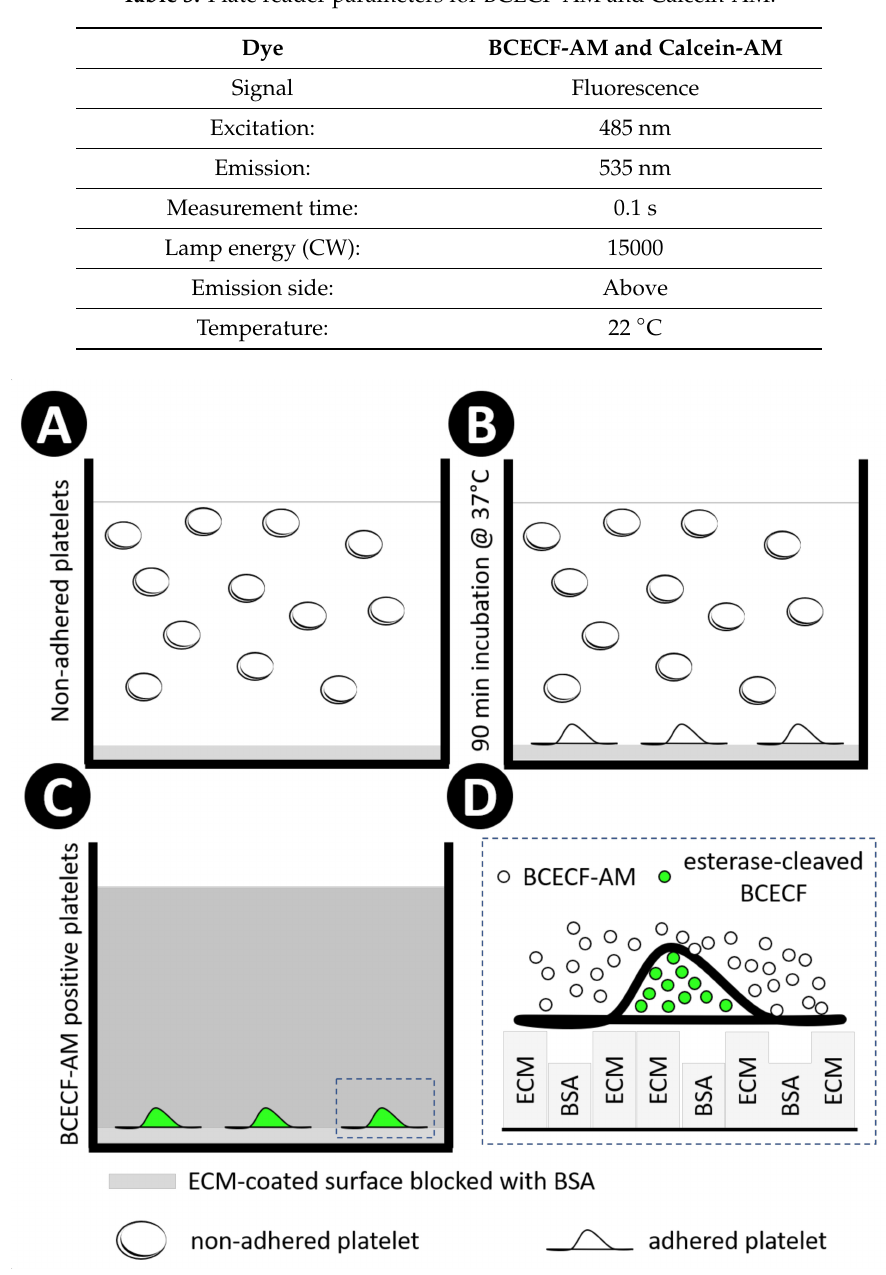
Figure 7. Schematic representation of the study design using BCECF-AM. Extracellular matrix proteins were employed to coat 96- or 384-well microplates, followed by BSA blocking, both incubated for 1 h at 37 ◦ C. Next, human washed platelets were added into wells ( A ). and incubated for 90 min at 37 ◦ C ( B ). Non-adherent platelets were washed away with tyrode bu ff er, and adherent platelets were incubated with diluted BCECF-AM for 30 min at 37 ◦ C. The excess of BCECF-AM was removed by washing the plate 3 times with tyrode bu ff er ( C ). Non-fluorescent BCECF-AM is permeable to the platelet membrane. Once inside the platelet, intracellular esterases cleave the ester bond, releasing BCECF, which is the fluorescent form of the molecule. In addition, the cleavage of lipophilic blocking groups by esterases, leads to a charged form of BCECF, which leaks out of cells more slowly than BCECF-AM [69]. Rectangular boxes represent ECM and BSA coating ( D